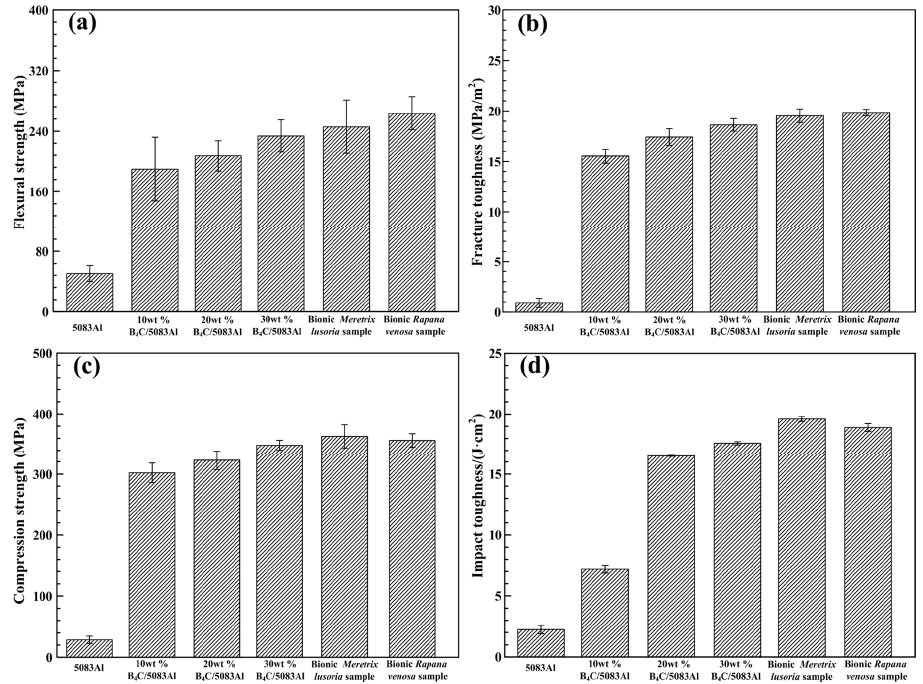
Figure 6. ( a ) Flexural strength; ( b ) Fracture toughness; ( c ) Compression strength and ( d ) Impact toughness values of 5083Al, B 4 C/5083Al composite materials, bionic Meretrix lusoria shell and bionic Rapana venosa shell layered composite materials.